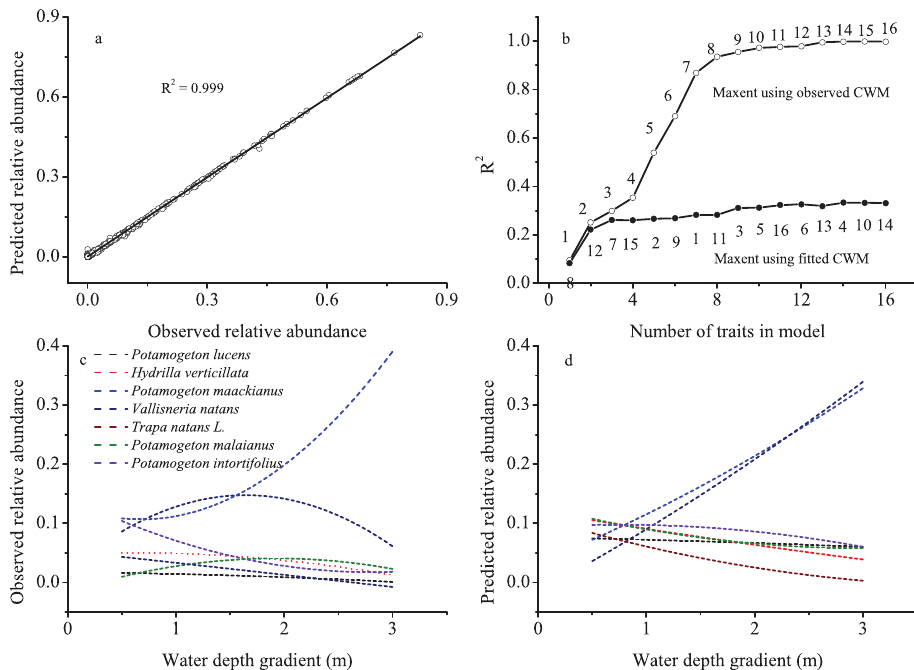
Fig 2. Results of a backward stepwise analysis of maximum entropy (maxent) model using community-weighted mean trait (CWM) constraints. (a) Observed vs. predicted relative abundances of 17 macrophyte species over 42 plots using observed sixteen CWM traits. (b) Relationship between the amount of explained variance of maxent model and the number of traits used in the model. Open circles represent models that used observed CWM traits as constraints, while filled circles represent models that used fitted CWM traits as constraints. Filled circles represent models in which traits were entered into the model in the order at which they are listed from left to right, based on how well they could be predicted from water depth gradient. The numeral codes showed in this chart indicates: 1-lamina thickness, 2-floating leaf, 3-perennial growth form, 4-rooting depth, 5-stem diameter, 6-tuber, 7-leaf nitrogen content, 8-stem dry mass content, 9-leaf dry mass content, 10-ramet size, 11-leaf carbon/nitrogen ratio, 12-leaf carbon content, 13-specific leaf area, 14-shoot height, 15-flowering duration, 16-mean Julian flowering dates. General linear models of observed (c) and predicted (d) relative abundances of seven common macrophyte species presented in Erhai Lake along water depth gradient. The predicted relative abundances used here were generated with the maxent model using the seven community-weighted mean trait constraints that were best predicted from water depth